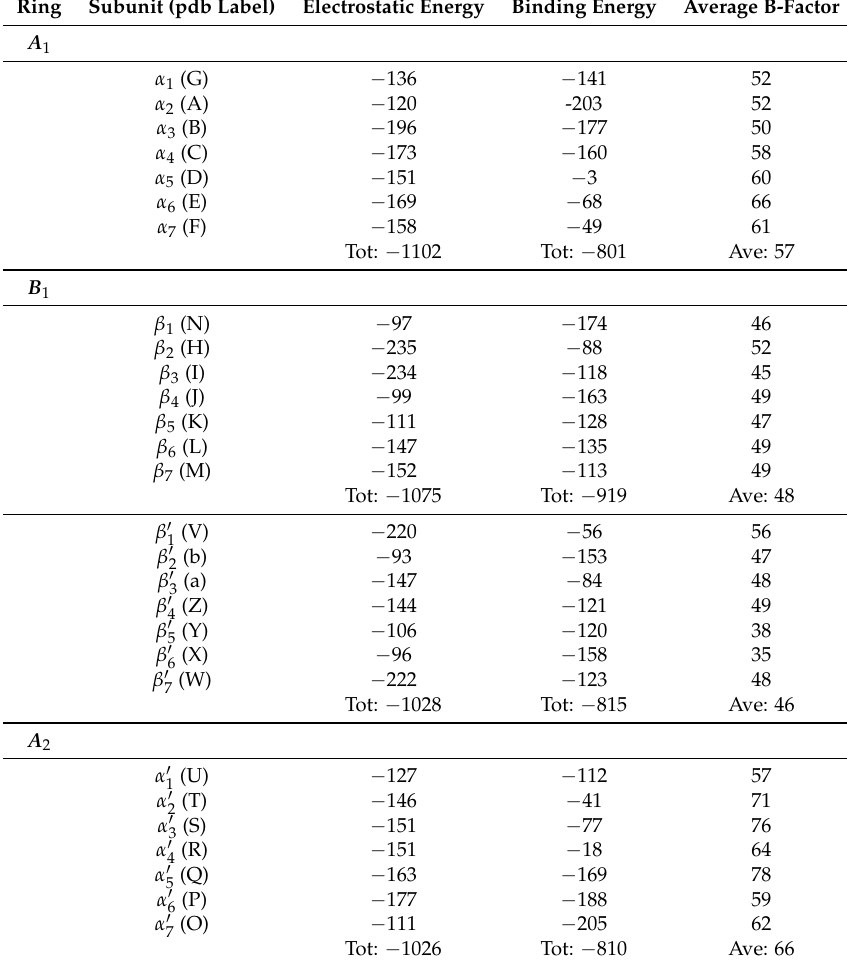
Table A1. Electrostatic potential energy, binding energy (each given in [kcal/mol]), and average B-factor of each proteasome ring subunit. The corresponding chain symbol (A–Z, a, and b) from the PDB file 5CZ4.pdb is listed in the parentheses after each subunit. For each of the two B rings, the three subunits ( β 1 , β 2 , β 5 ) containing the active sites are marked in bold. The table arrangement of rings is according to the spatial arrangement in the proteasome: A 1 , B 1 , B 2 , A 2